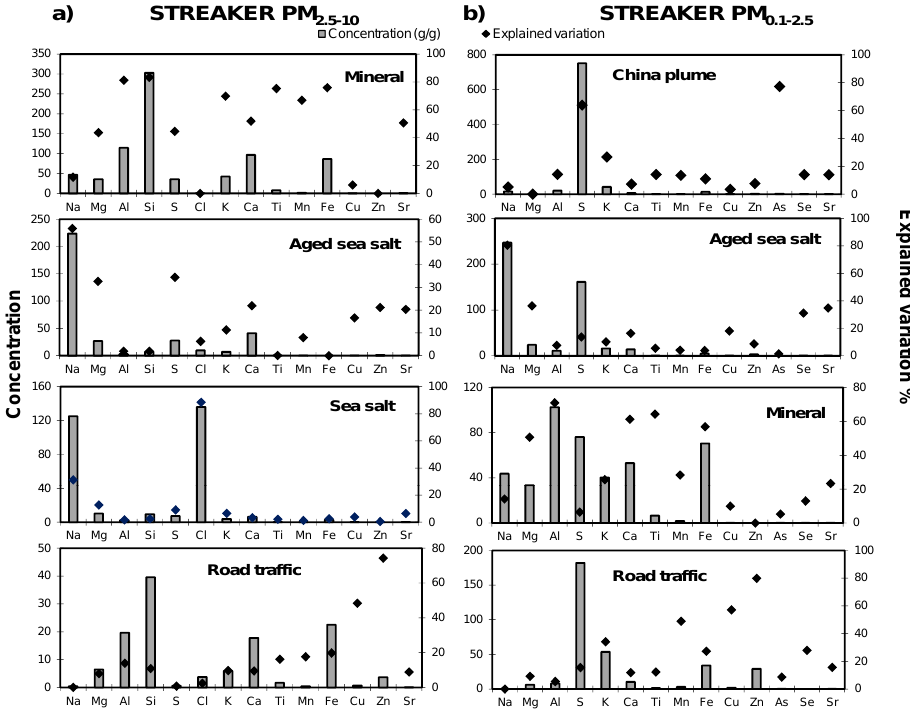
Fig. 2. Chemical profile for each factor identified by Positive Matrix Factorization (PMF) for hourly Streaker samples showing concentration histograms and the explained variation for each